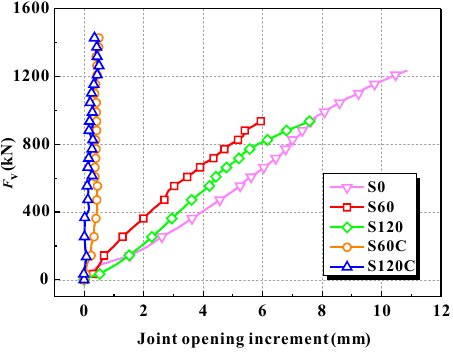
Figure 16. Load versus joint opening increment.